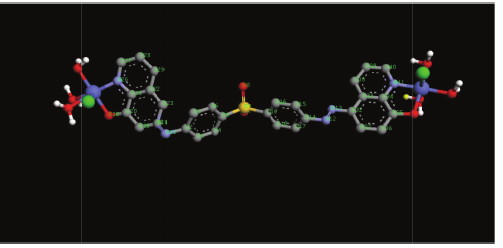
Figure 3: Optimised geometry of [Co 2 LCl 2 (H 2 O) 6 ] complex.